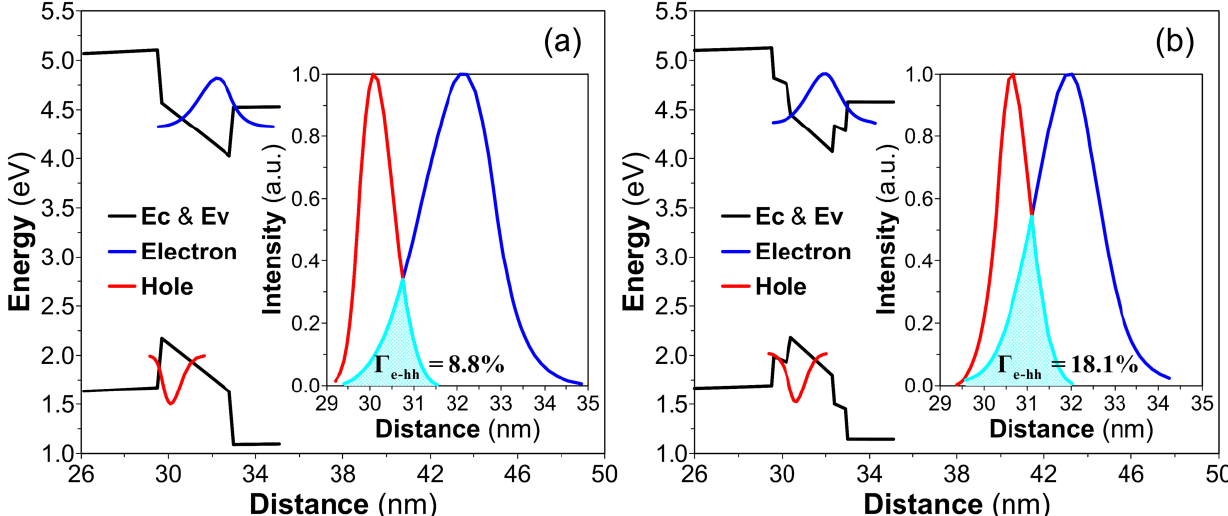
Figure 6. Energy band diagrams and wavefunctions of ( a ) regular and ( b ) staggered quantum wells with the input current equal to 300 mA. The zoom-in images of electron and hole wavefunctions for both kinds of quantum wells are plotted in the insets. Here Γ e-hh represents the integral overlap of electron and hole wavefunctions.